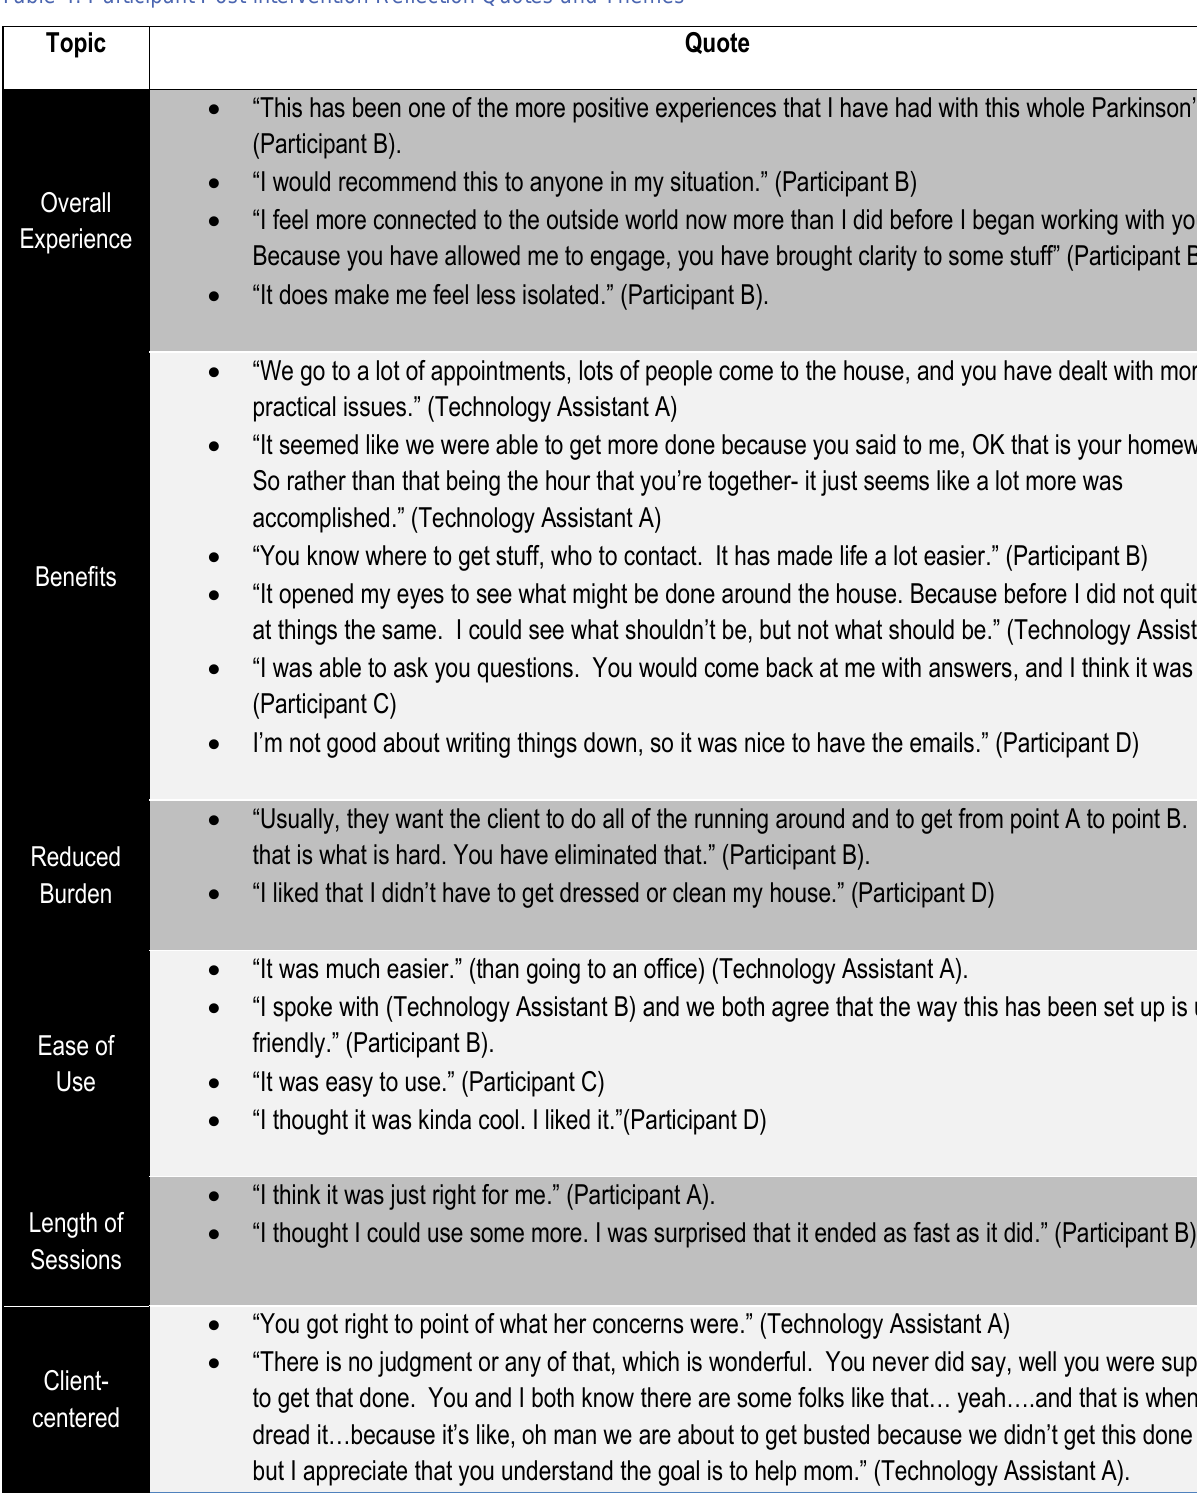
Table 4. Participant Post-intervention Reflection Quotes and